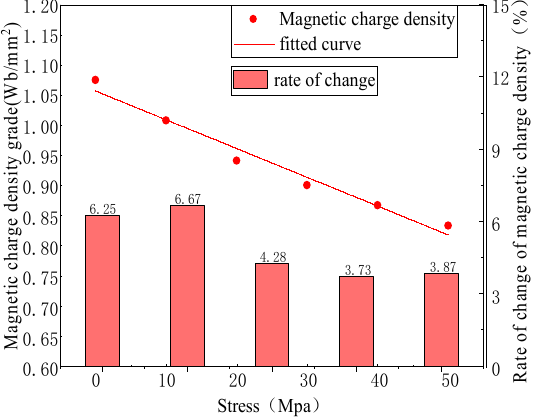
Figure 5. Relationship between stress and magnetic charge .